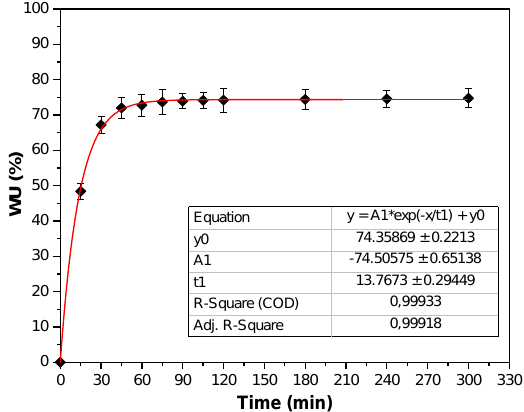
Figure 8. Water uptake of SPI films.